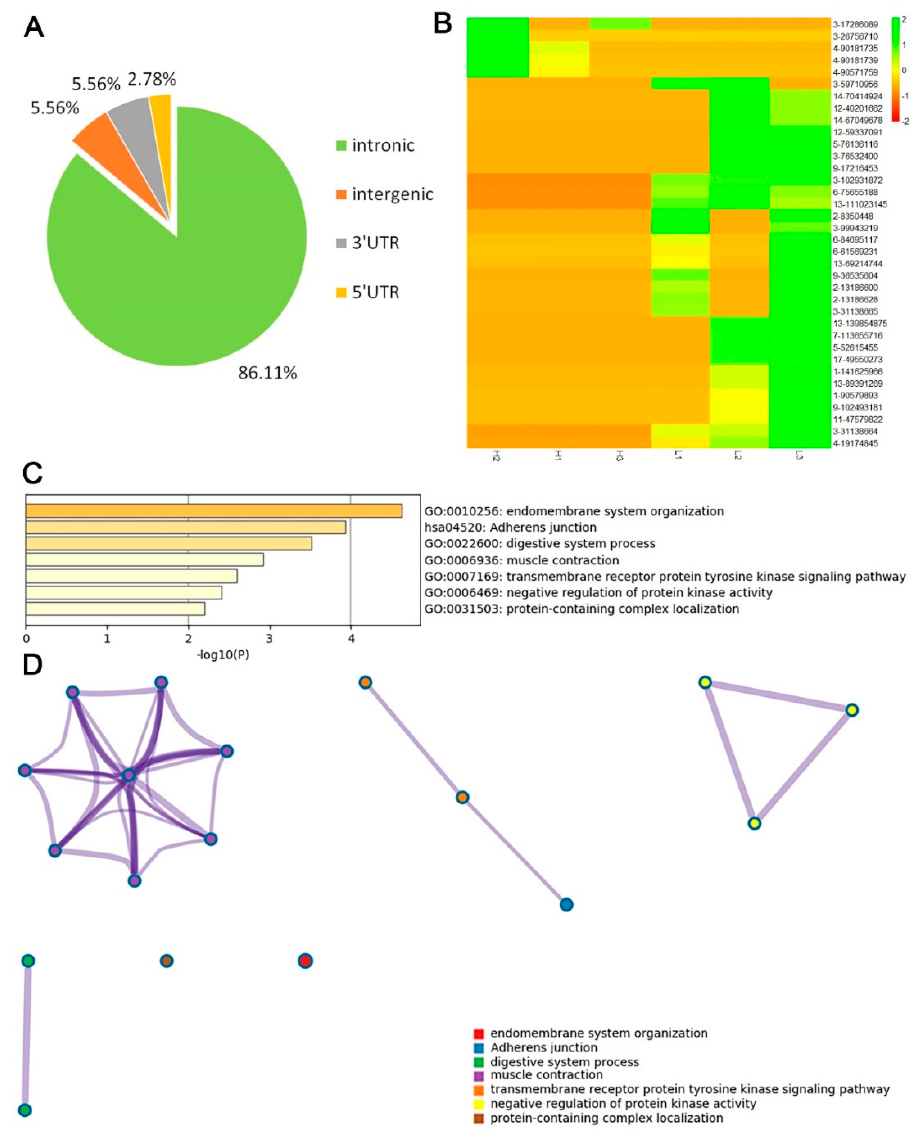
Figure 6. Distribution and function analysis of genes containing differential RNA editing sites. ( A ) Genomic features of hyper- and hypo-editing sites in genes. ( B ) Cluster heatmap of differential editing sites. Different color represents different editing level. ( C ) Most significant GO biological function of the genes with hyper- or hypo-editing sites. ( D ) The interactome network of the genes with hyper- or hypo-editing sites. Different biological functions are represented in different colors.